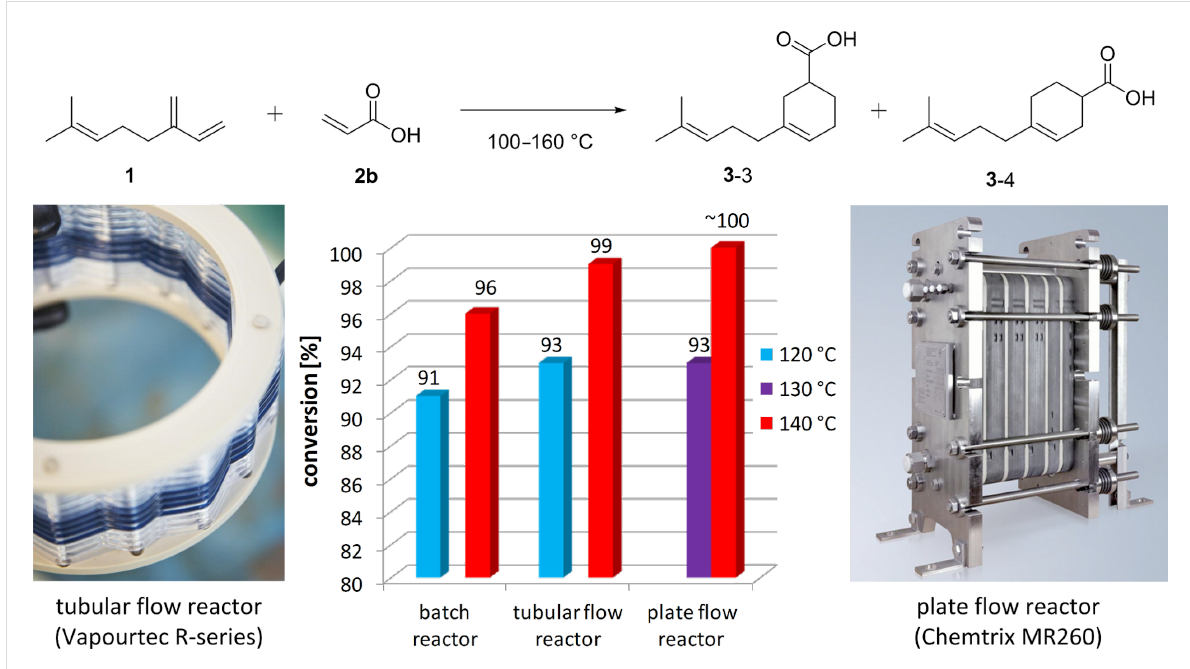
Figure 2: Comparison of conversions in three different reactors for the Diels–Alder reaction of myrcene ( 1 ) with acrylic acid ( 2b ) in toluene; the reac- tion forms two isomers, 3 -3 and 3 -4; reaction temperature for these experiments: 120, 130 or 140 °C, reaction time: 40 min; photographic images of a tubular reactor coil of the Vapourtec R2/R4 flow reactor [26] and of the plate reactor module of the Chemtrix Plantrix ® MR260